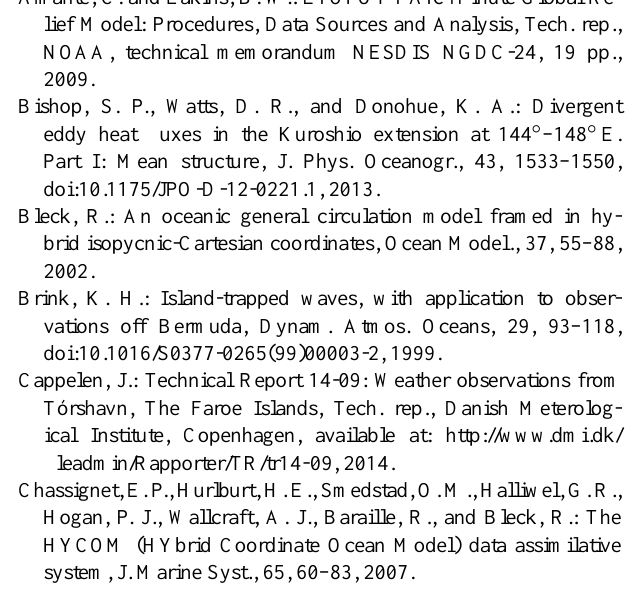
6-day timescales (not shown). The wind EKE in the 2–6-day band (Fig. 13) shows a maximum in winter (when EKE in the mooring data is low) and a minimum in summer (when EKE in the mooring data is high) indicating that the observed variability in the plume region is not atmospherically